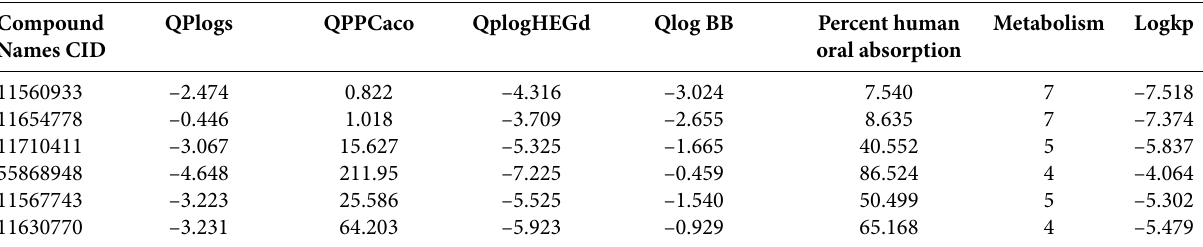
Table 6. Estimated physicochemical and pharmacokinetic parameters by